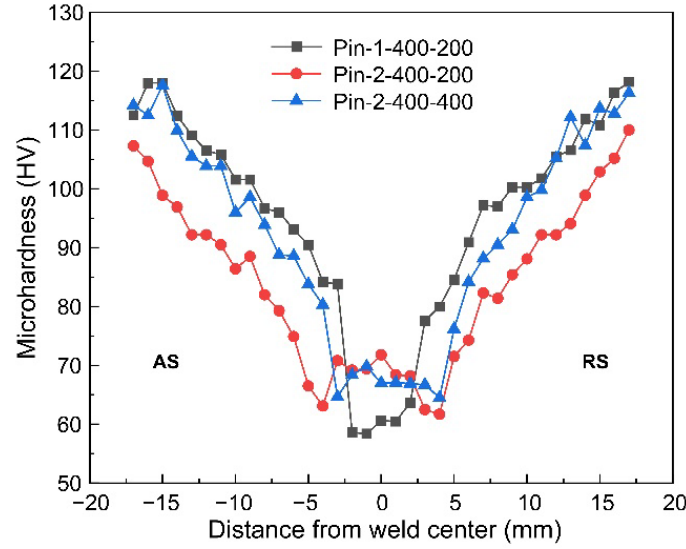
Figure 13. Microhardness distributions of bottom layers.